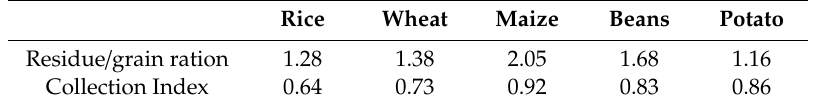
Table A1. Crop residue / grain ration and collect index in AHP. Rice Wheat Maize